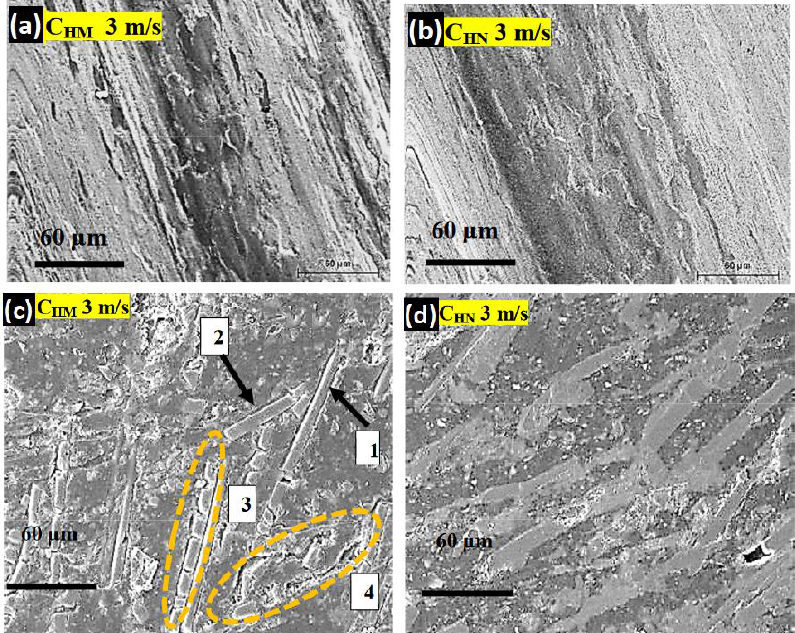
Figure 16. SEM images of ( a , b ) worn disc surfaces of C HM and C HN under 900 N and 3 m s −1 ; ( c , d )